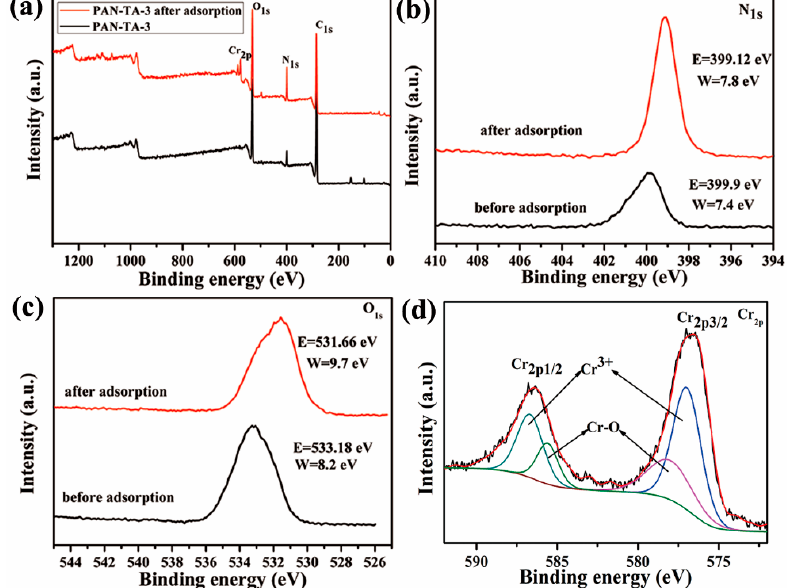
Figure 8. XPS spectra of ( a ) PAN–TA-3 before and after adsorption of the Cr(III)–collagen complex, high-resolution scan of ( b ) N 1S before and after the adsorption of complex, high-resolution scan of ( c ) O 1s , and high-resolution scan of ( d ) Cr 2p .